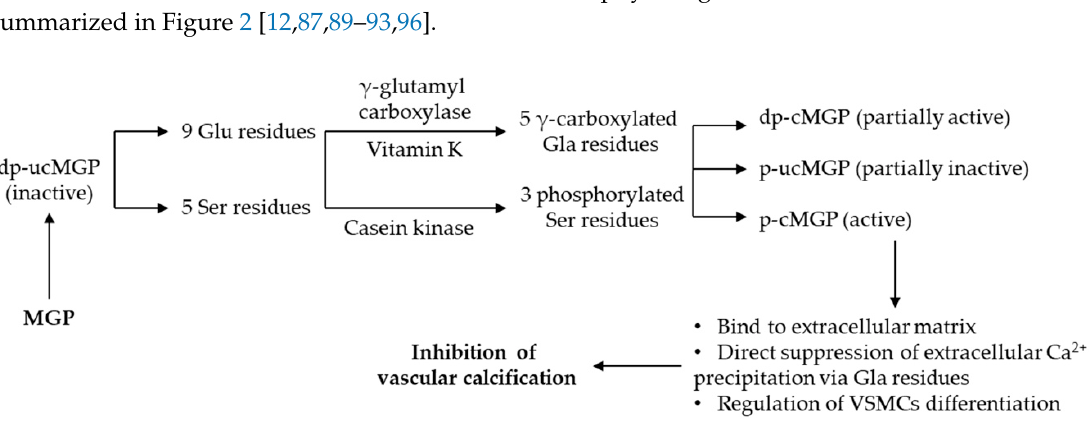
Figure 2. Molecular mechanisms and physiological function of MGP. Abbreviations: MGP, matrix gla protein; Glu, glutamic acid; Gla, γ -carboxy-glutamic acid; Ser, serine; dp-ucMGP, dephospho-uncarboxylated MGP; p-ucMGP, phosphorylated-uncarboxylated MGP; p-uMGP, phosphorylated-carboxylated MGP; VSMCs, vascular smooth muscle cells.